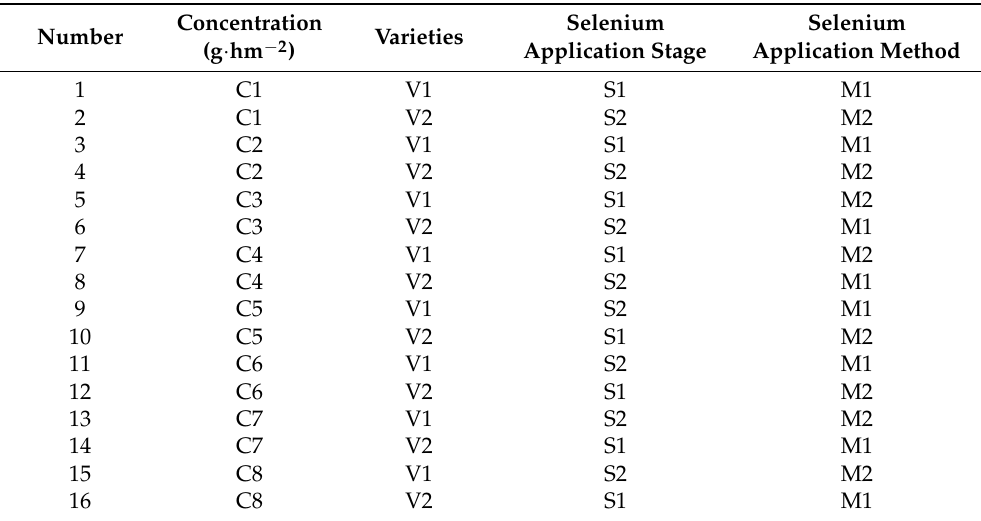
Selenium Varieties Application Stage